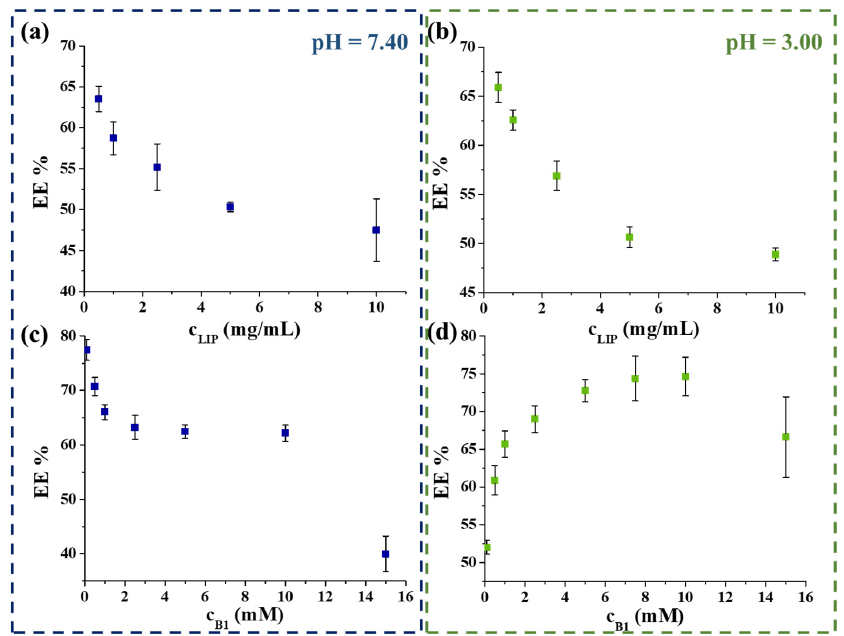
Figure 2. The obtained EE % as a function of the concentration of the applied asolectin ( a , b ) and vitamin B 1 ( c , d ) at pH = 7.40 (left) and at pH = 3.00 (right) conditions.